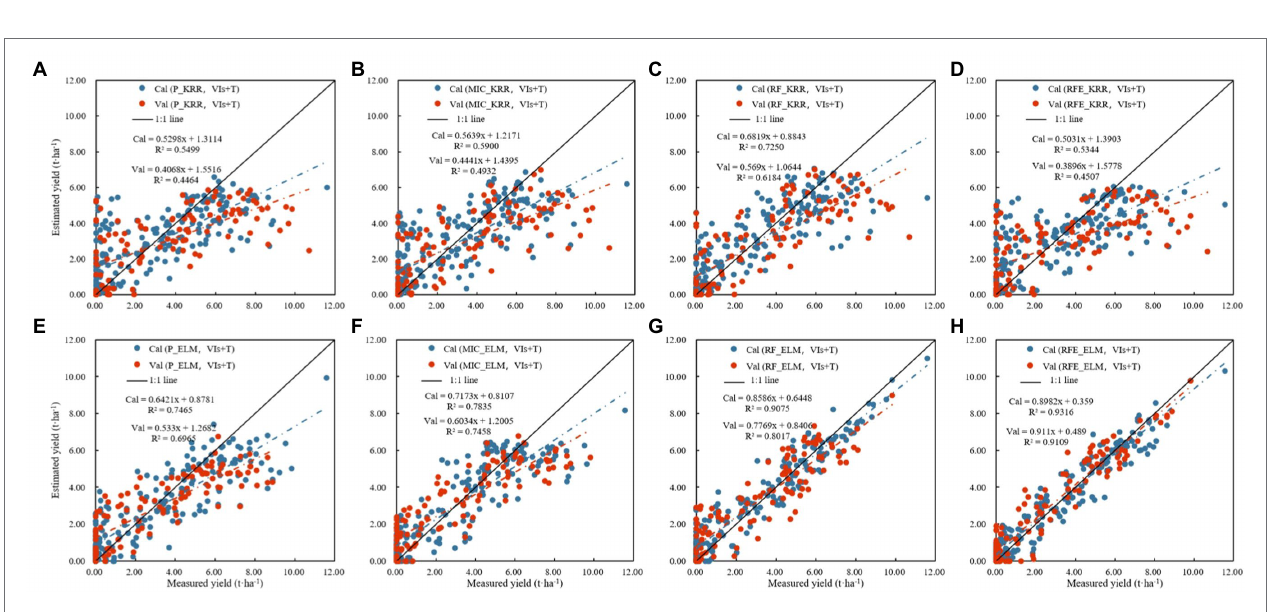
FIGURE 11 | Cotton yield estimation models established by best performing based on the vegetation indices and texture features by using the linear and nonlinear models. (Note: (A) P_KRR model; (B) MIC_KRR model; (C) RF_KRR model; (D) RFE_KRR model; (E) P_ELM model; (F) MIC_ELM model; (G) MIC_ELM model; (H) RFE_ELM